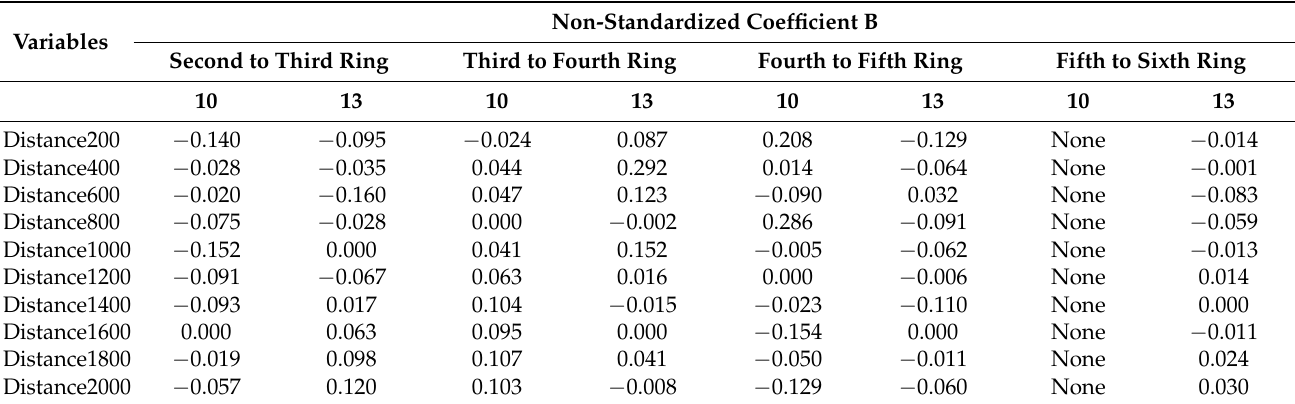
Table 4. Regression result coefficient for additional characteristic